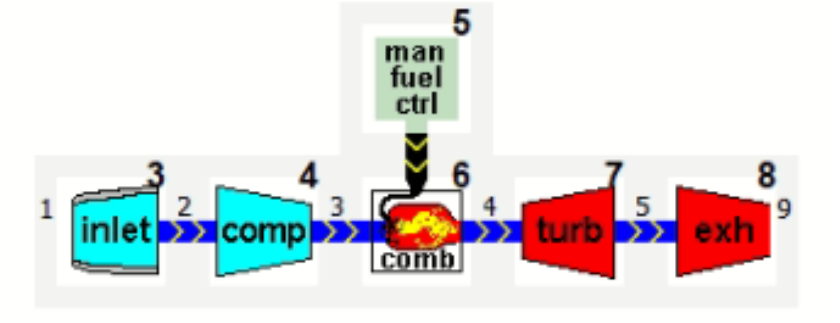
Figure 1. Turbojet model in GSP. The digits in fine print are engine stations while the larger ones are GSP component